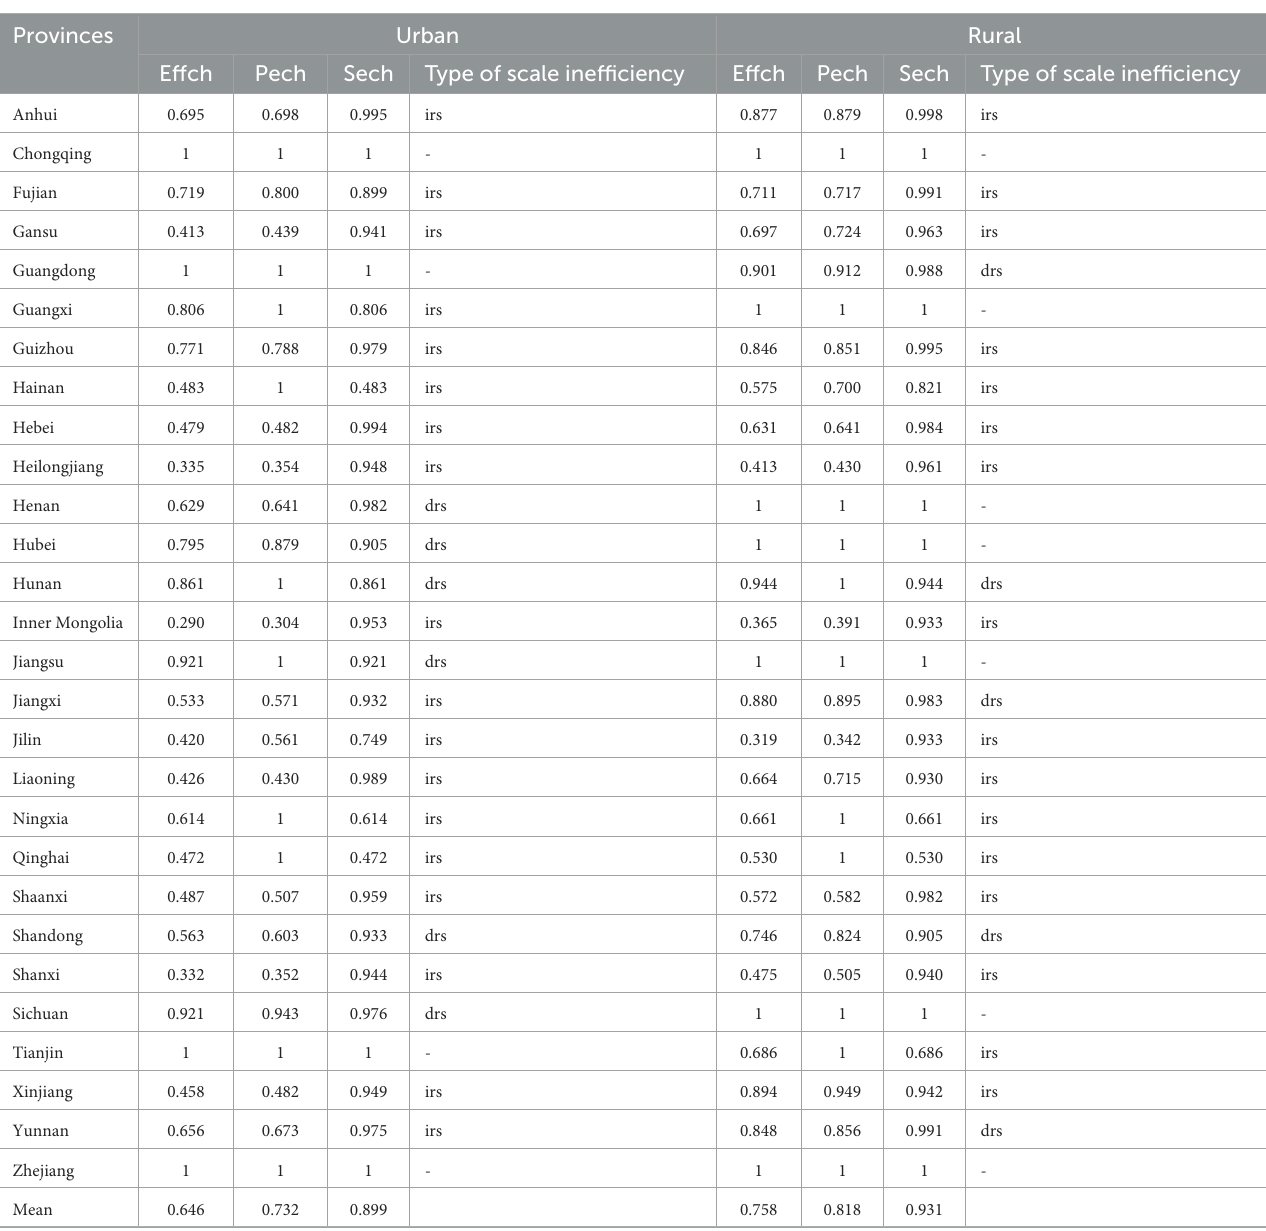
TABLE 3 DEA results of PHCIs in 2019.